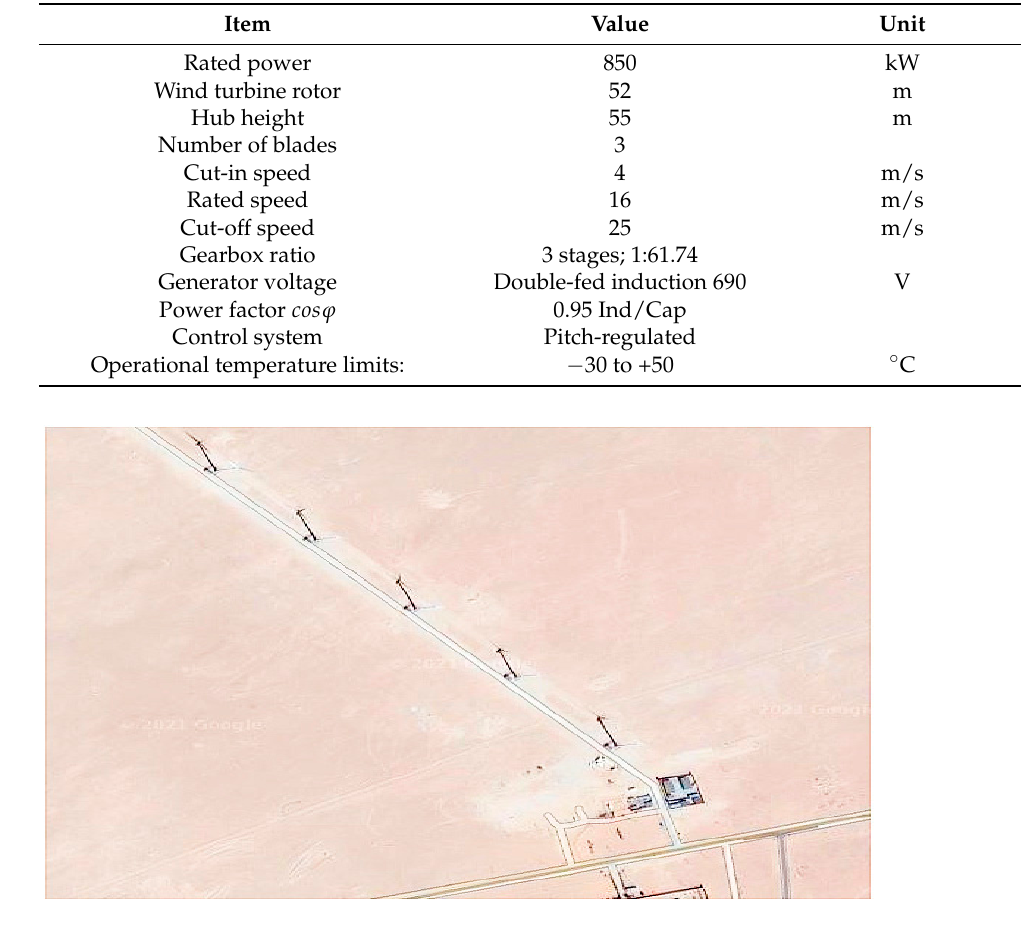
Figure 17. Typical configuration of twelve wind turbines (12 × 0.85 MW) at Kaberten wind farm.